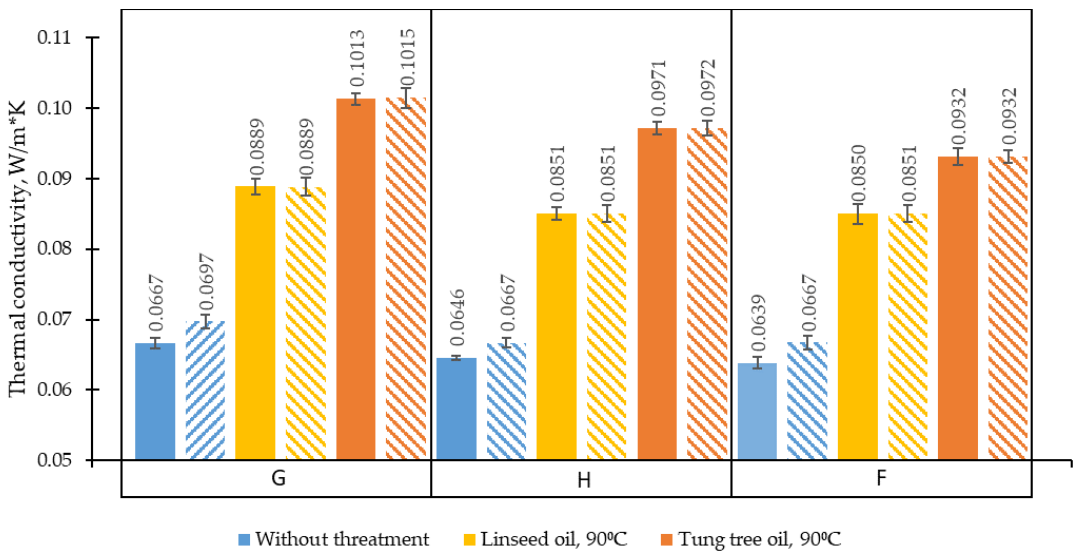
Figure 9. Thermal conductivity of different oil-impregnated BcBs. G, H, F—composition of boards, impregnated at 90 °C hardening temperature. —linseed oil, —tung tree oil, —without oil treatment: solid-type bars—specimens which were dried at 70 °C to constant weight; pattern-type bars—specimens which were conditioned at (23 ± 2) °C and (50 ± 2)% to constant weight.